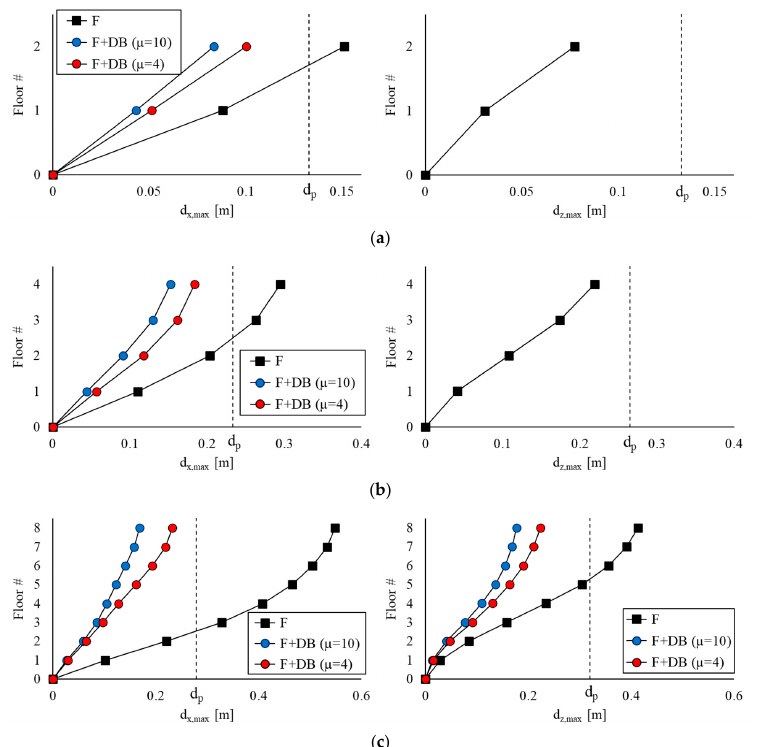
Figure 12. Maximum displacement at each floor of case-study MRFs with and w/o damped braces: ( a ) two-story, ( b ) four-story, and ( c ) eight-story structures.